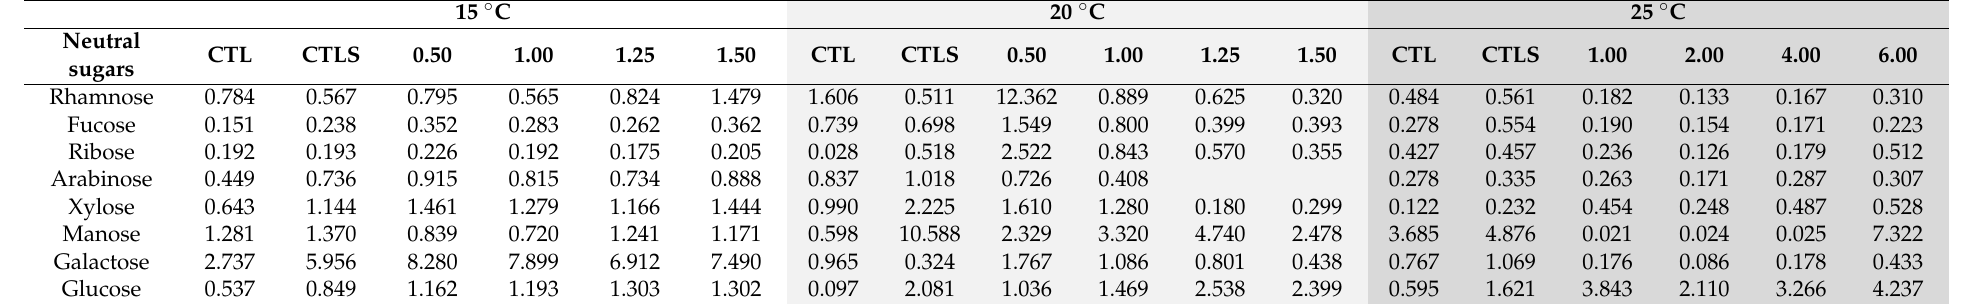
Table 6. Neutral sugar quantification ( µ g/10 4 cell) of Thalassiosira weissflogii, determined in organisms after 7 days of exposure to five concentrations of oxyfluorfen ( µ g/L) at three different